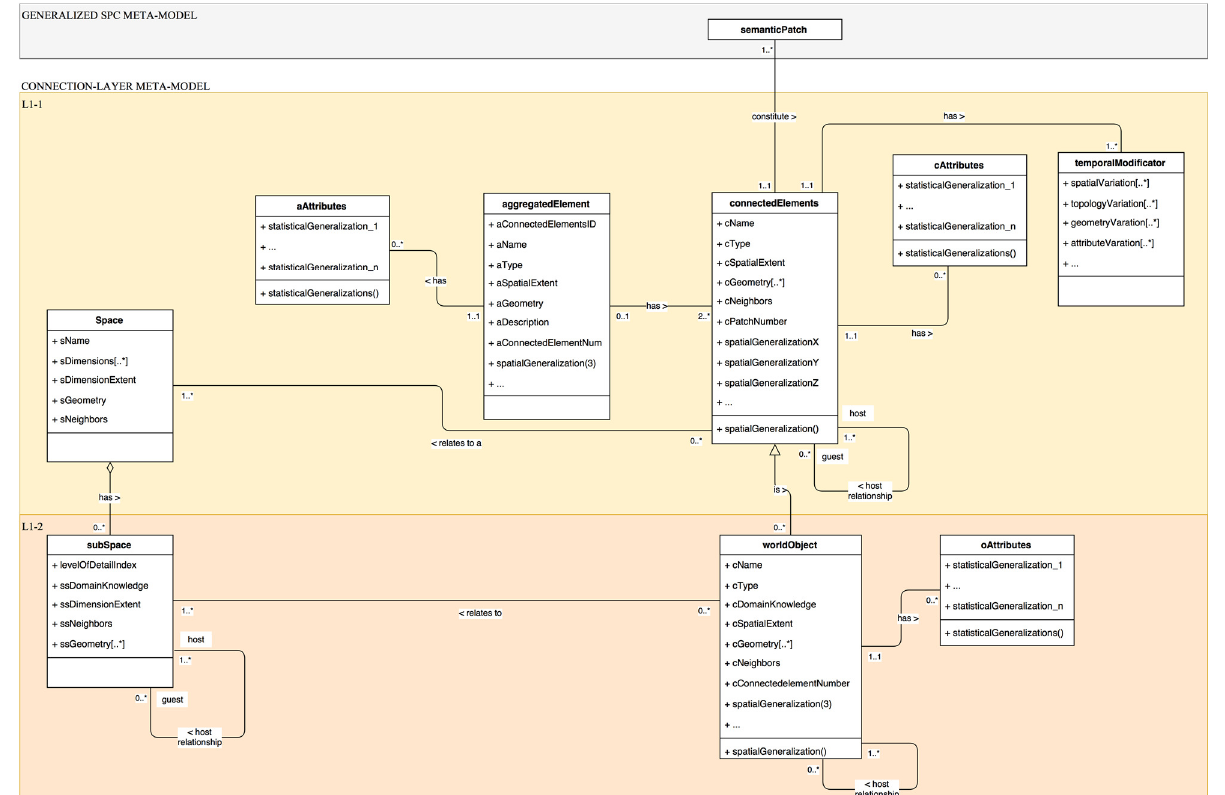
Figure 4 Level-1 Connection-layer meta-model. It is directly linked to the Level-0: semantic patches constitute connectedElements. aggregatedElements and topological notions gives flexibility to the deepness of an element characterization. ConnectedElements can relate to one or multiple spaces defined by their dimensions. These are subsequently divided in subspaces regarding a concept from a domain knowledge characterization, similarly to the world objects (being a specialization of